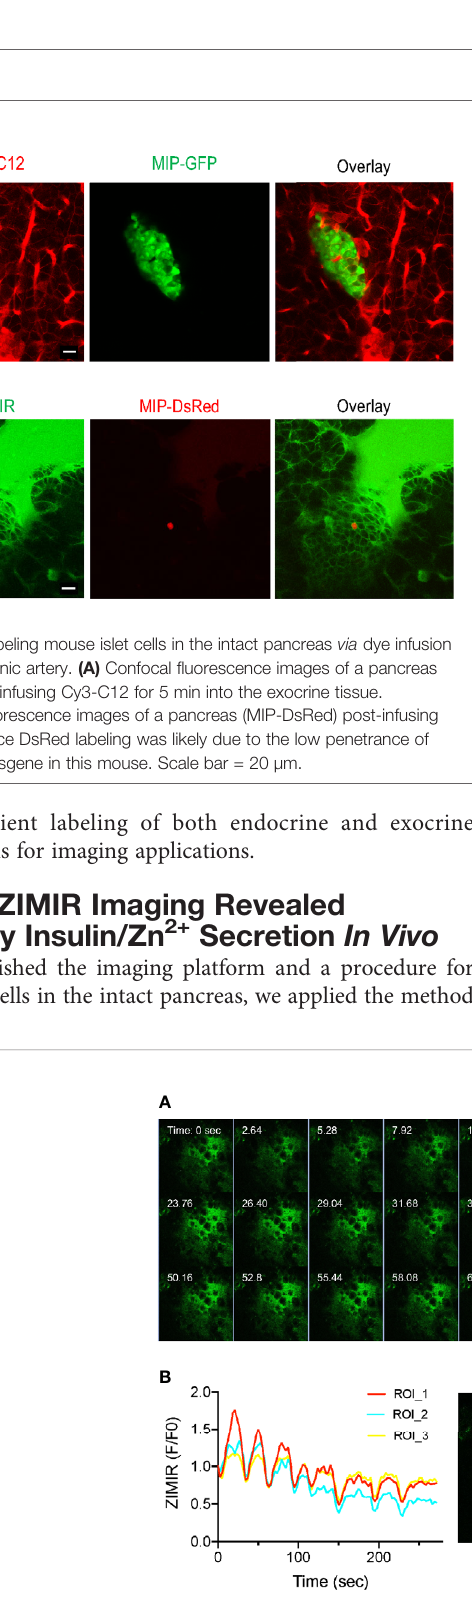
FIGURE 4 | Intravital ZIMIR imaging showed oscillatory insulin/Zn 2+ release of mouse islet cells. (A) Time lapse confocal ZIMIR images of pancreatic islet cells of a mouse under anesthesia. The mouse received a glucose injection just before the imaging session. Scale bar = 20 µm. (B) Time course of ZIMIR signal in three regions of interest (ROI) as indicated in the image to the right. (C) Average oscillation period of insulin/Zn 2+ release (mean ± stdev) calculated from the time course shown in (B)